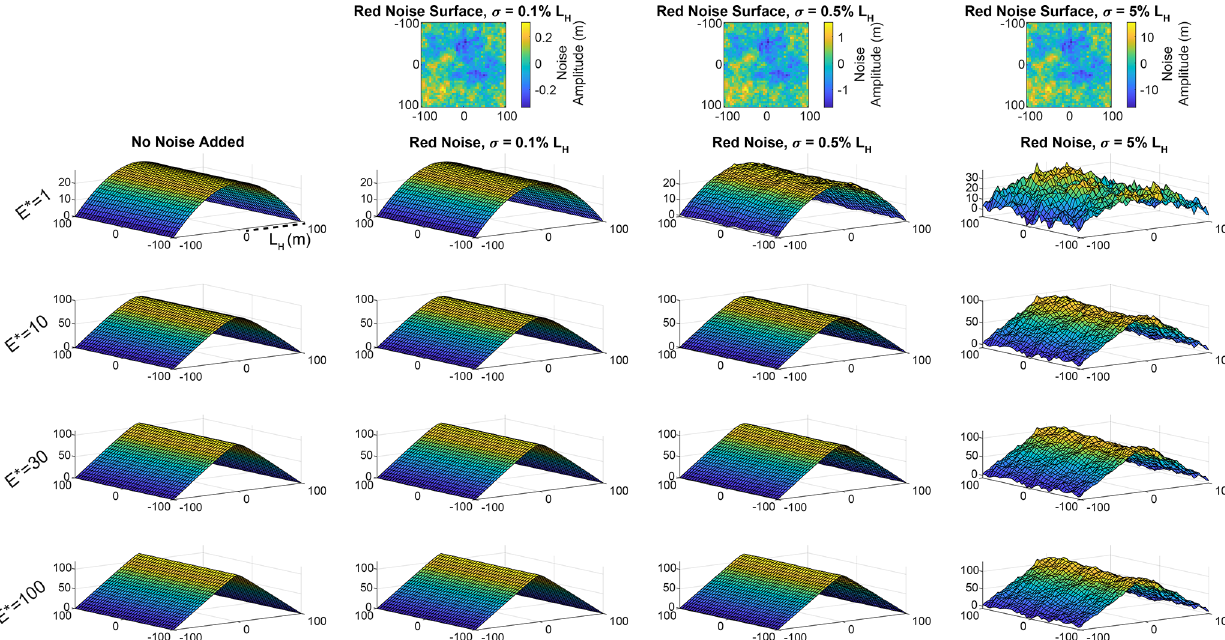
Figure 9. Synthetic hillslopes constructed using Eq. (11). Same as Fig. 8, but with red noise added (see the Supplement for white noise example). Upper row shows red noise surfaces added to the original hillslope form (left column); yellow colors correspond with positive deviations from the hillslope (convex noise) and blue with negative deviations (concave noise). Each row of hillslopes corresponds with dimensionless erosion rates from E ∗ = 1–100. Note the increased prominence of planar hillslopes as E ∗ increases. Noise does not vary with E ∗ ; thus the magnitude of noise relative to hillslope relief is more visually apparent at lower E ∗ (see σ = 5% L H column for clear example). Note that compared to Fig. 8, the surface noise exhibits longer wavelength noise, made apparent by larger concave and convex regions. Note that all results in Fig. 10d, h, i, and p correspond with the third column here ( σ = 0 . 5% L H ). See the Supplement for corresponding figures for other σ = 0 . 1% L H and σ = 5% L H